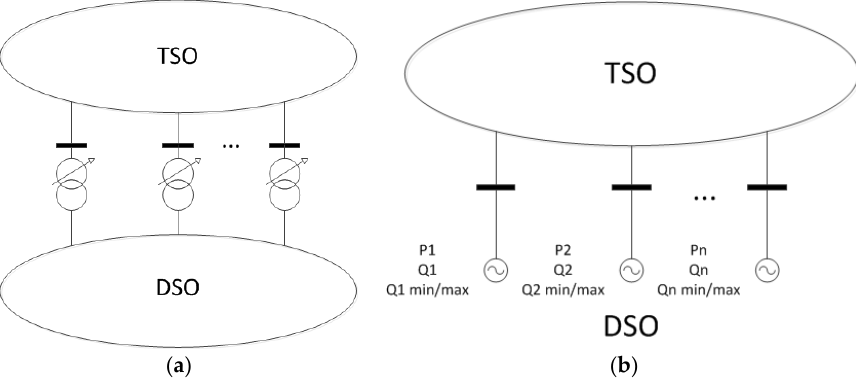
Figure 7. Regional grid model comprising both TSO and DSO ( a ), and Transmission system grid model with distribution grid transformers seen as virtual generators ( b ).